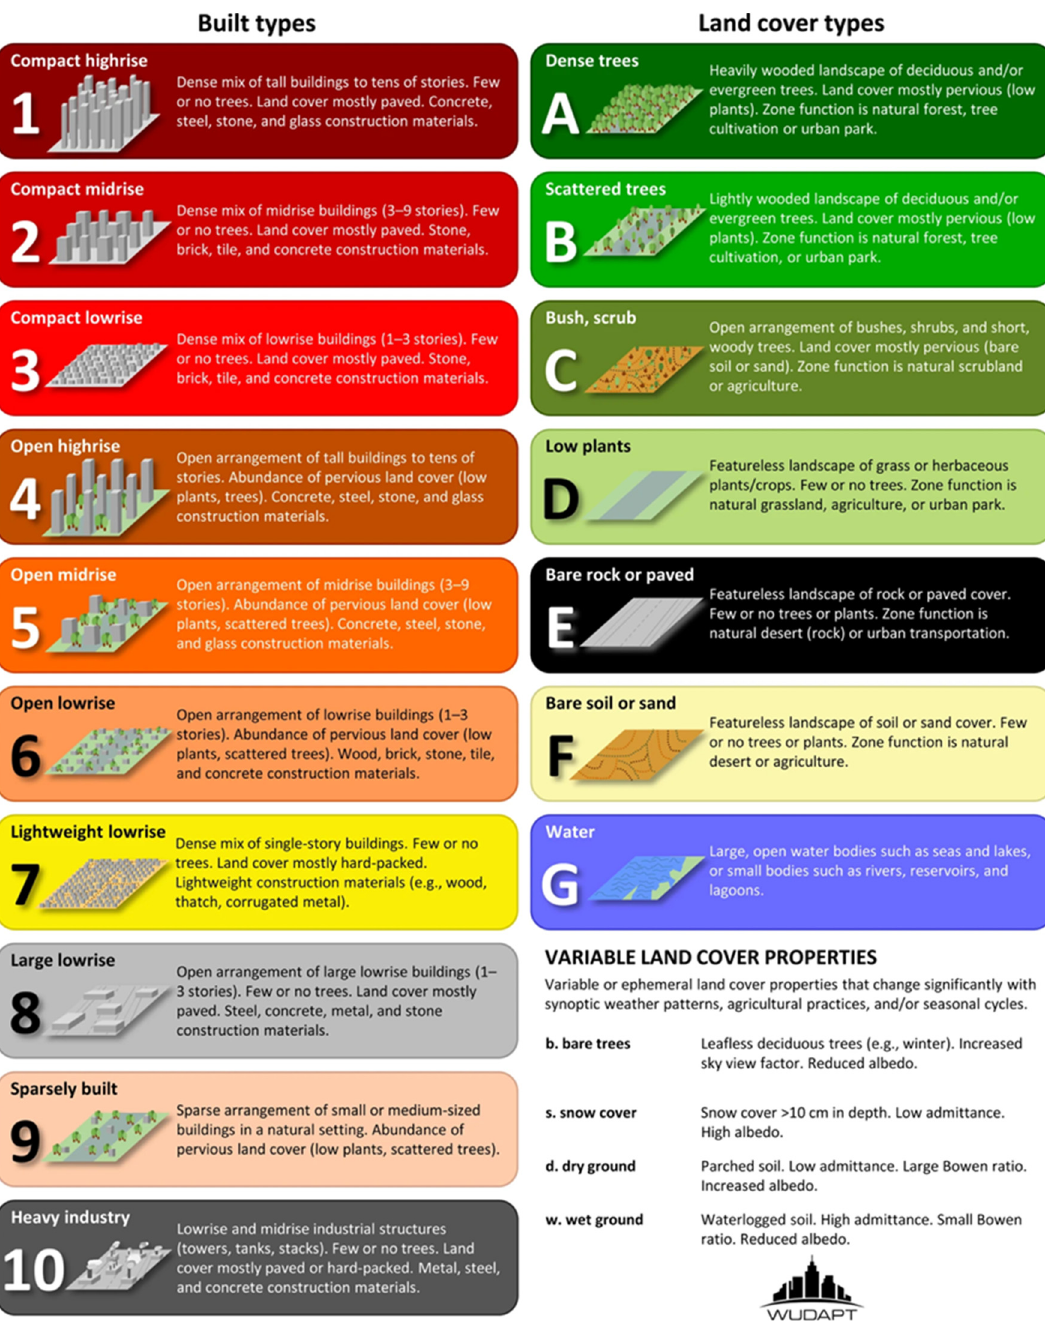
Figure 1. LCZ classification scheme [7].